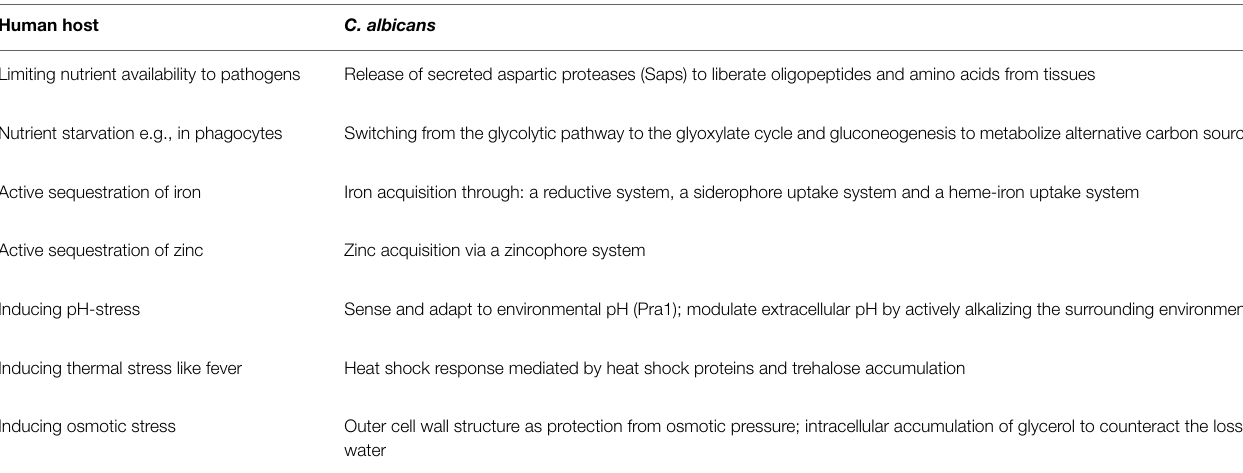
TABLE 1 | Pairs of defense and evasion strategies—adapting to the host environment. Human